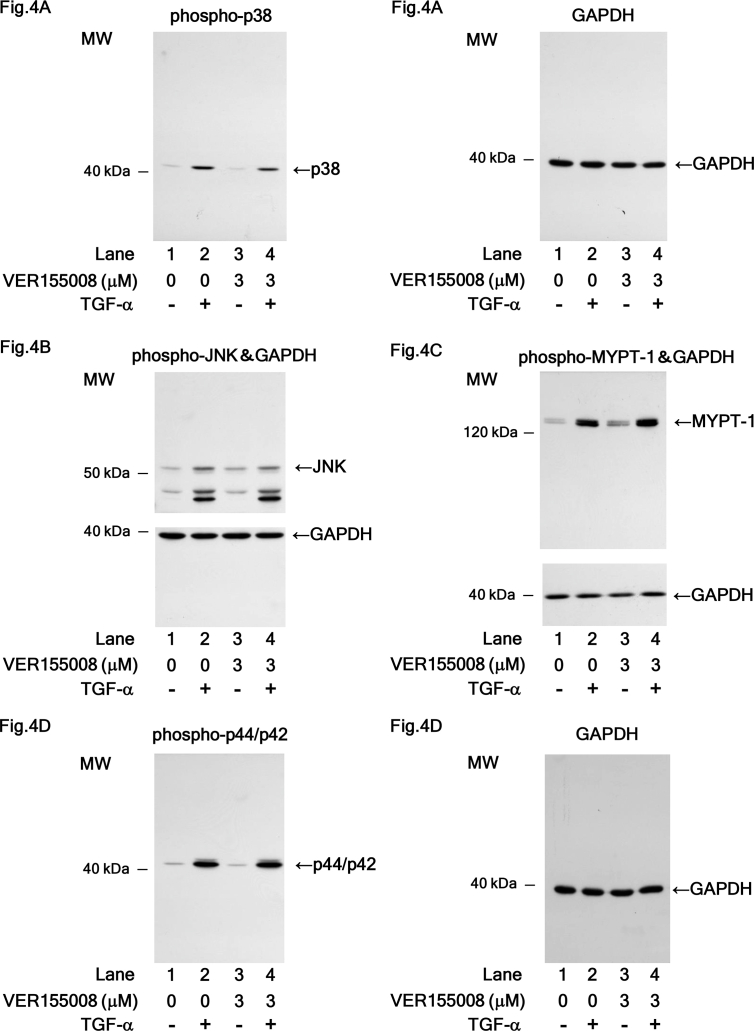
Figures S1, S2 and S4. For Figures 4B, 4C, 5 and 7, the blotted membranes have been cut just above 40 kDa according to protein markers in order to examine the phosphorylated proteins and GAPDH as a housekeeping protein on the same membrane. Therefore, the top (for the phosphorylated proteins) and the bottom (for GAPDH) of each membrane have been detected separately. Thus, the images of these figures are cropped.